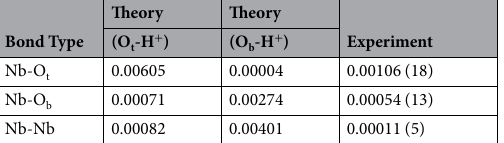
Table 1. Bond Disorder ( σ 2 , in Å 2 ): Theory vs.